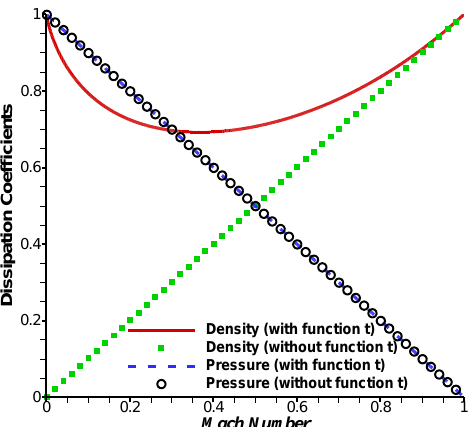
Figure 7. Dissipation coefficients of the pressure and the density.